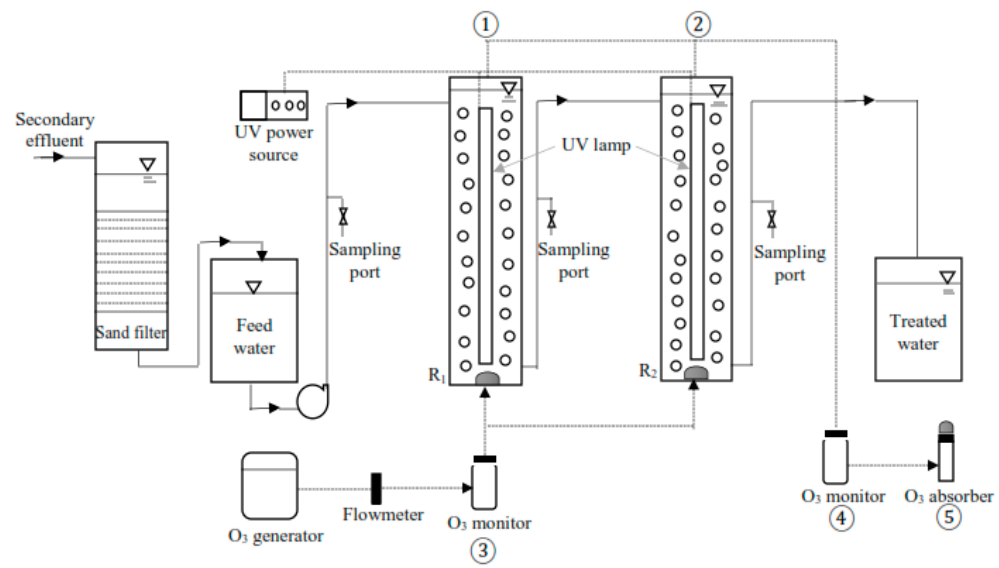
Figure 1. Schematic diagram of the experimental process.